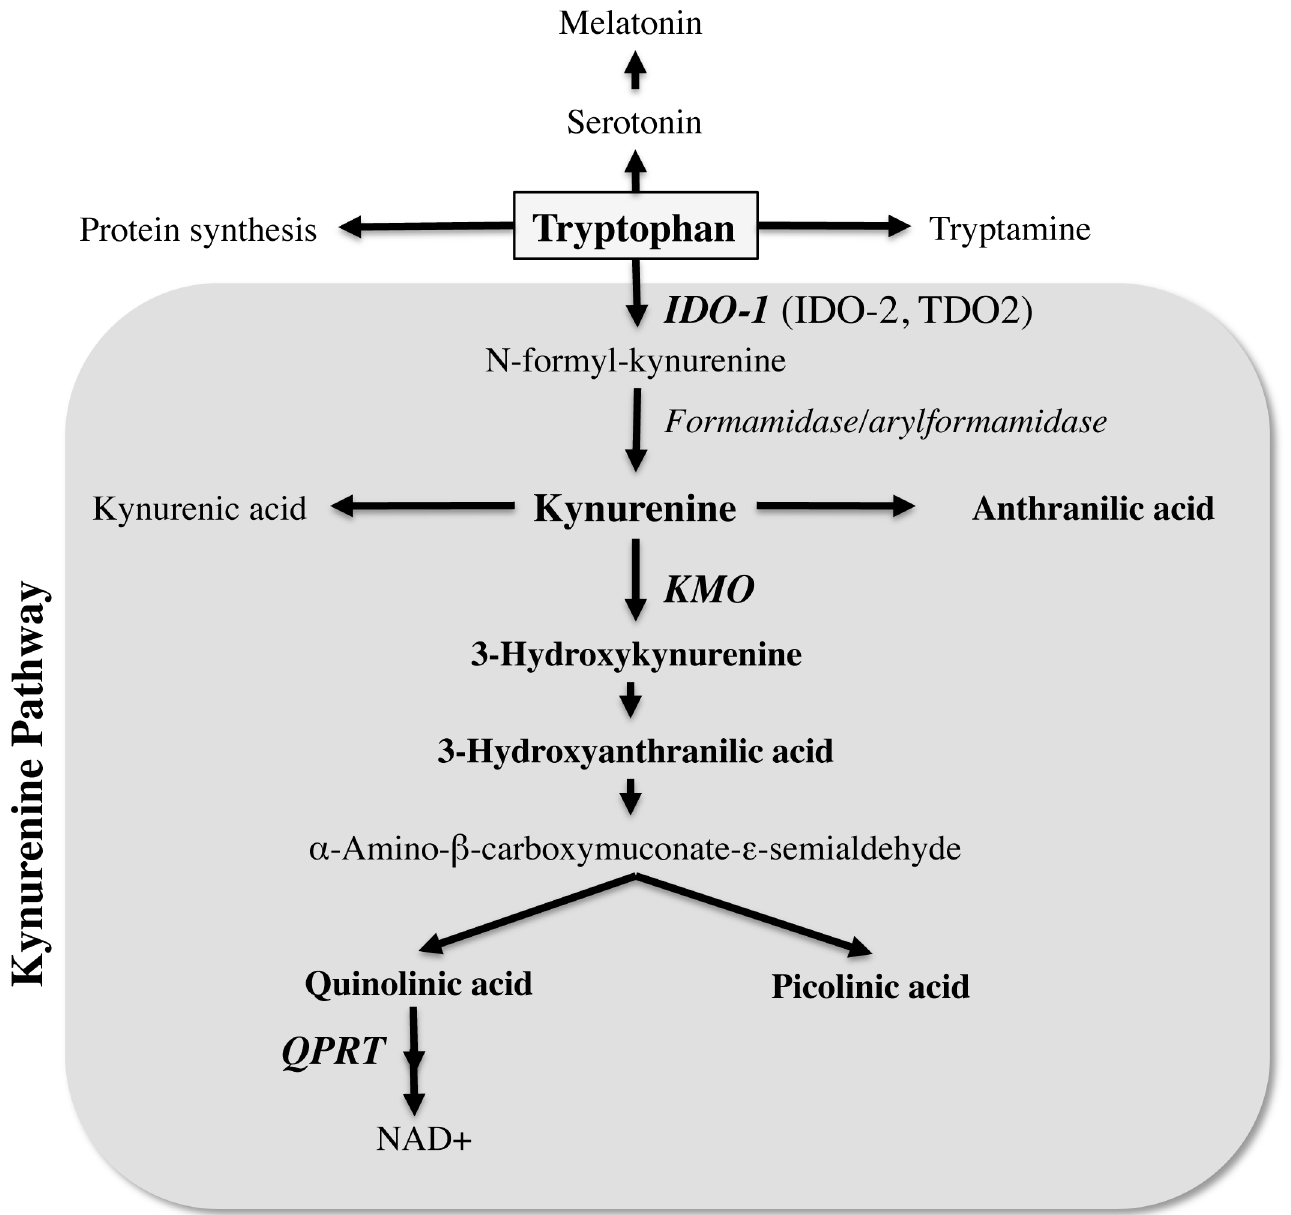
Fig 1. Simplified overview of the kynurenine pathway of tryptophan metabolism. The three main enzymes: indoleamine 2,3-dioxygenase (IDO-1), kynurenine 3-monooxygenase (KMO) and quinolinate phosphoribosyltransferase (QPRT) are shown abbreviated in bold italics whilst the main metabolites measured in this study are written in